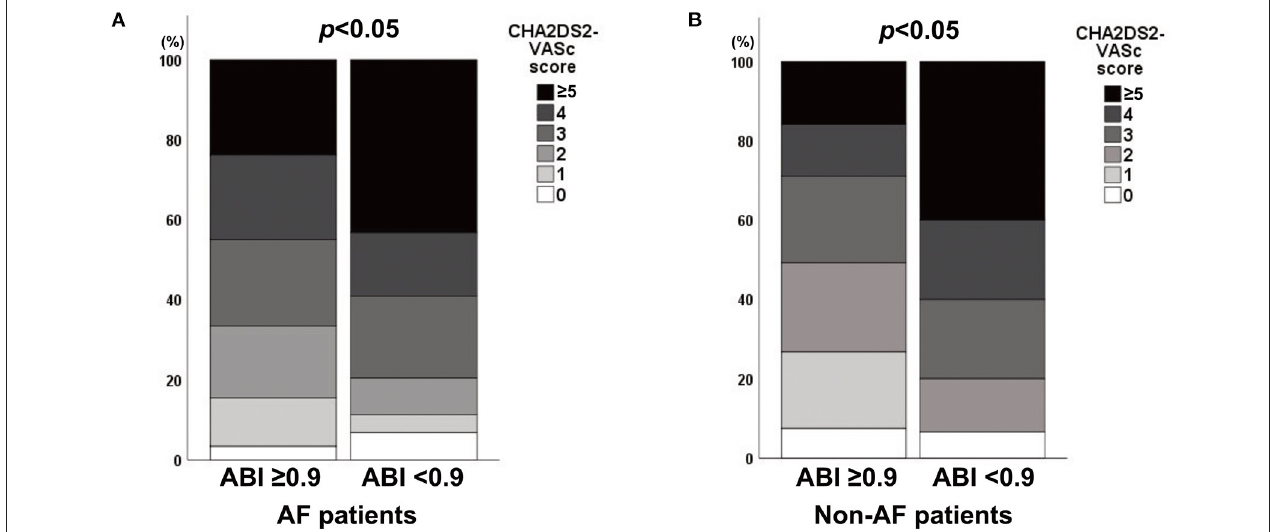
FIGURE 2 | Association between the CHA 2 DS 2 -VASc score and an ABI < 0.9 in (A) AF and (B) non-AF patients. ABI, ankle-brachial index; AF, atrial fibrillation.